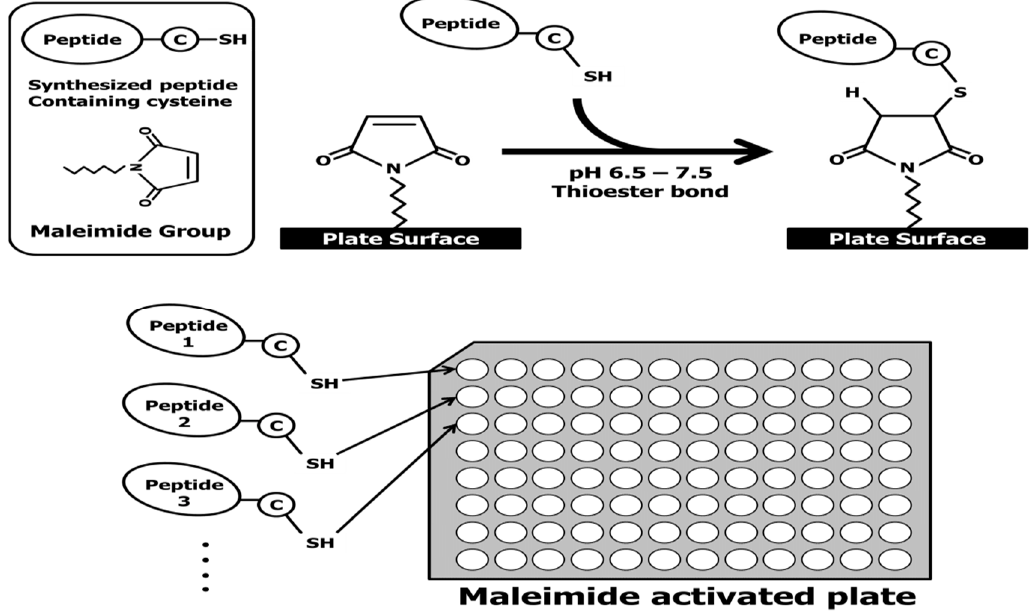
Figure 6. Synthetic A β 42 fragments were coated on maleimide-activated plates and the principle of epitope-mapping enzyme-linked immunosorbent assay (ELISA) applied.